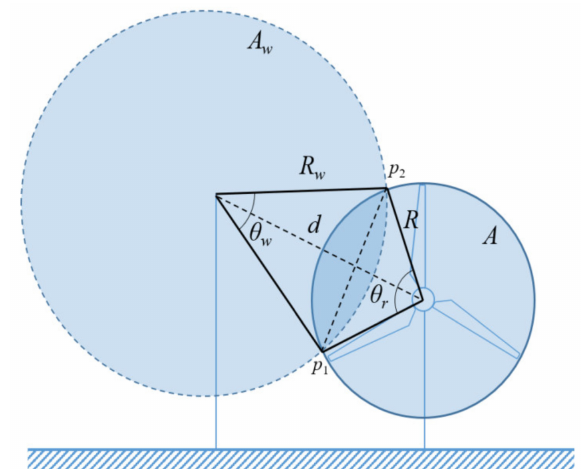
Figure 2. Wake shadow area